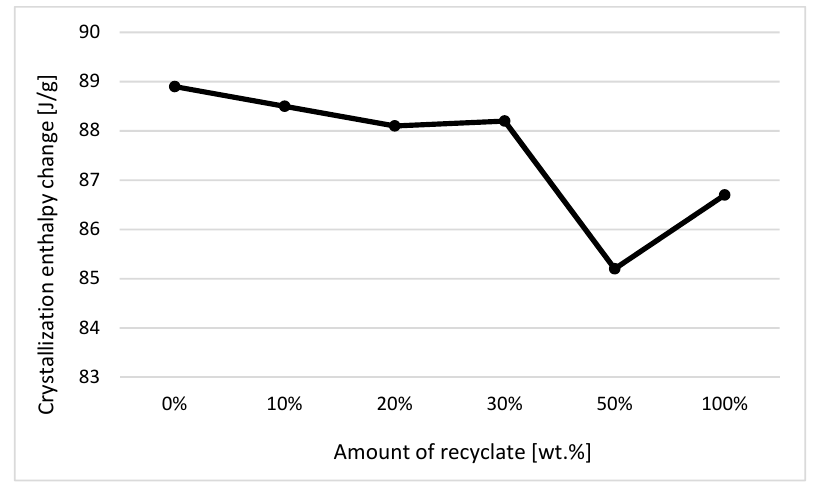
Figure 3. Dependence of the change in melting enthalpy on the proportion of weight of the recycled material before exposure of the samples to elevated temperature—component 2.